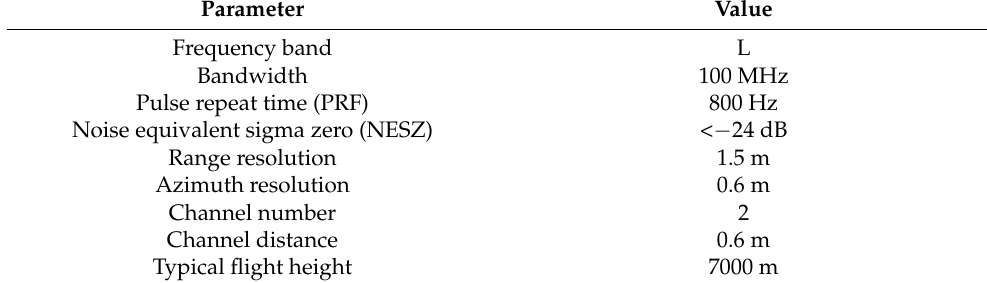
Table 3. Main parameters of Nriet-SAR L-band sensor.